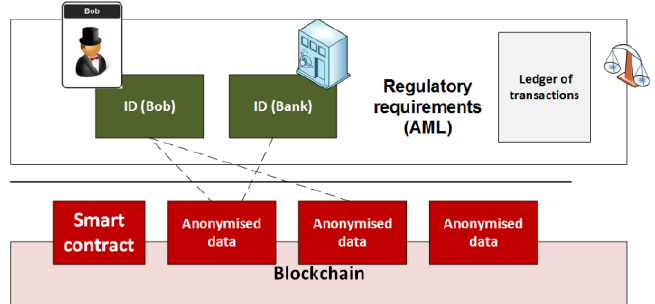
Fig. 5. Regulatory